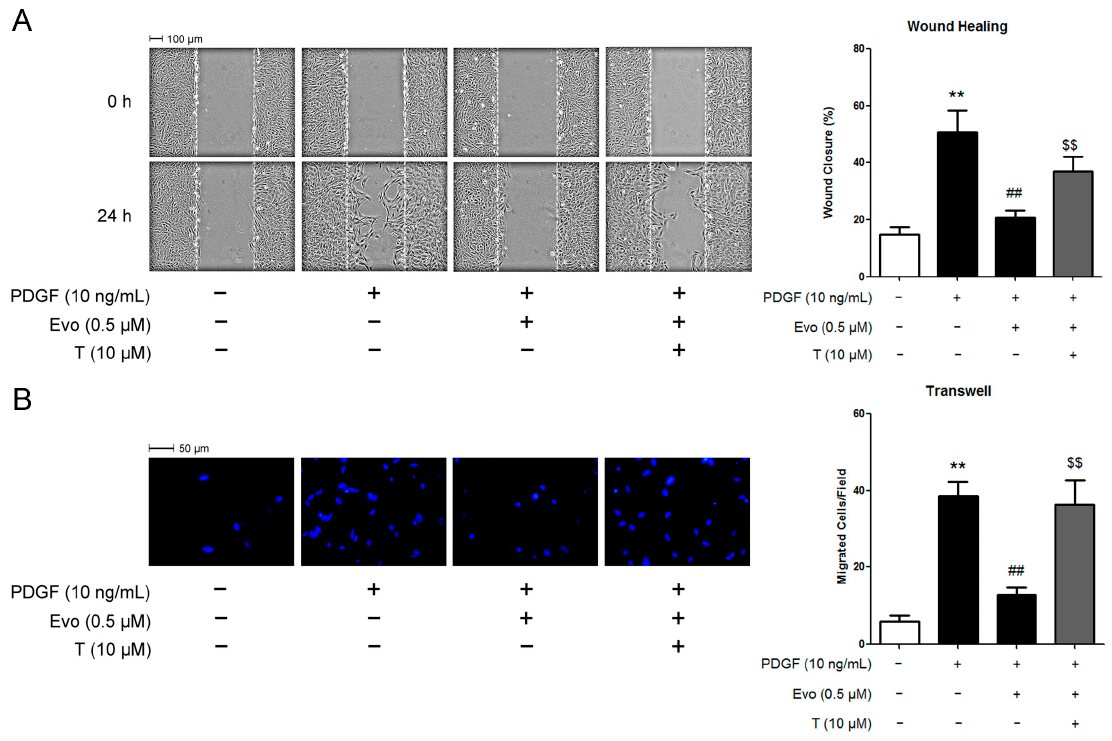
Figure 4. PPAR γ antagonist alleviated the inhibitory effects of evodiamine on PDGF-BB-stimulated VSMC migration. VSMCs were pretreated with 0.5 μ M evodiamine for 6 h and then stimulated with 10 ng/mL PDGF-BB for 24 h (wound healing) or 6 h (transwell). 10 μ M T0070907 was given 0.5 h in advance of evodiamine treatment when required. Cell migration was measured by using a wound healing assay ( A ) or a Boyden chamber transwell assay ( B ). In Panel B, blue color indicates cell nuclei stained with DAPI. Evo, evodiamine. T, T0070907. Data are represented as mean values ± SD of three independently prepared samples each with five measurements. ** p < 0.01 compared with the control group; ## p < 0.01 compared with the PDGF-BB-stimulated group; $$ p < 0.01 compared with the group treated with both evodiamine and PDGF-BB.